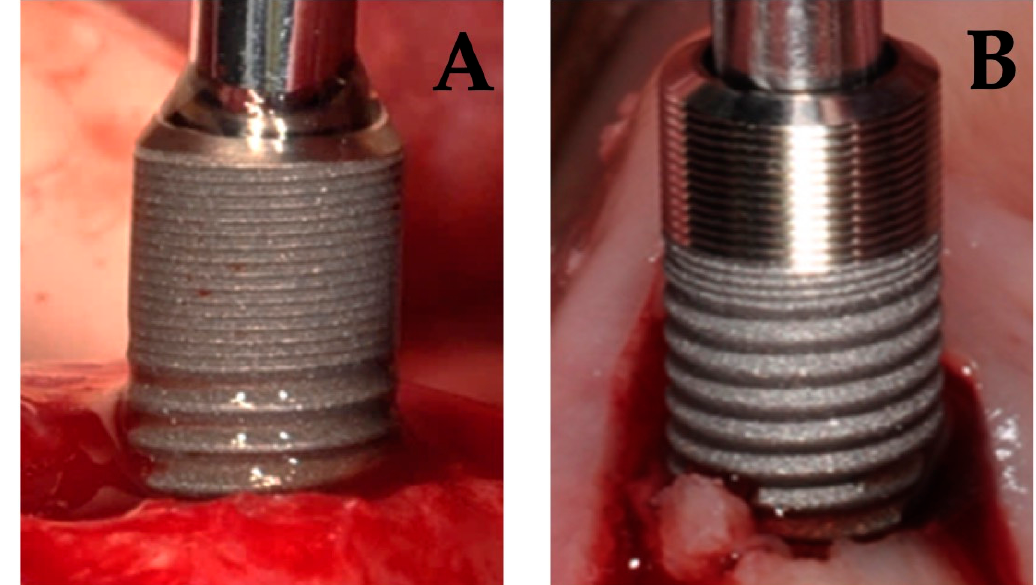
Figure 1. Placement of an implant with a moderately rough surface ( A ) and a hybrid implant with a minimally rough coronal neck ( B ).